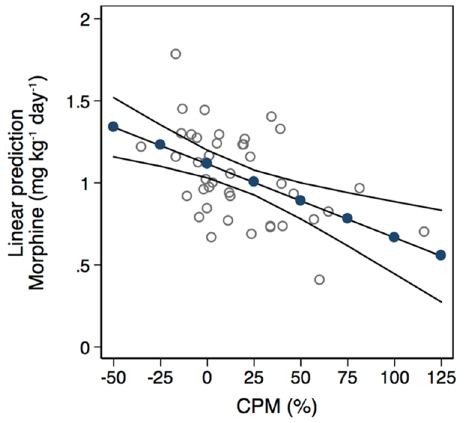
Figure 3. Preoperative situational pain catastrophizing and postoperative movement-evoked pain. Adjusted means (filled circles) with 95% confidence intervals (continuous solid lines) of the patient’s postoperative movement-evoked pain intensity (NRS 0–10) given different log-transformed values of preoperative situational pain catastrophizing (log[S-PCS]), adjusted for anxiety and depression by averaging across the values of the state part of the Spielberger’s State- Trait Anxiety Inventory (STAI) and Beck’s Depression Inventory (BDI) (average marginal values). The hollow circles represent overlaid scatterplots of log[S-PCS] versus postoperative movement-evoked pain intensity.